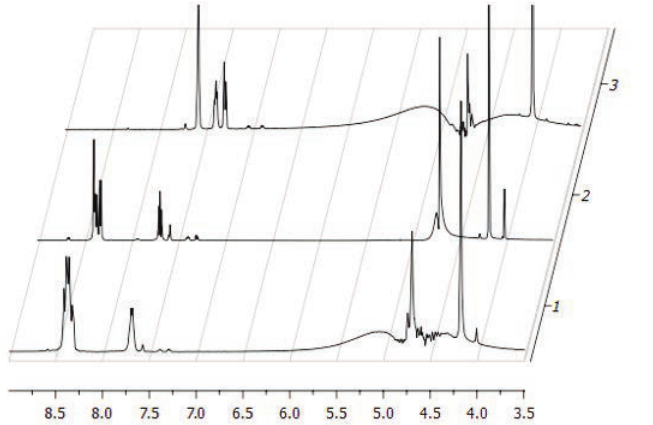
Figure 4. 1 H NMR (H O-D O mixture, 25 0 C, water suppression) spectra of 3a iodide (0,01 M phosphate buffer solution) in the presence 2 2 of 10-fold excess of H Table 2. Microwave-assisted preparation of compounds 2a-g .